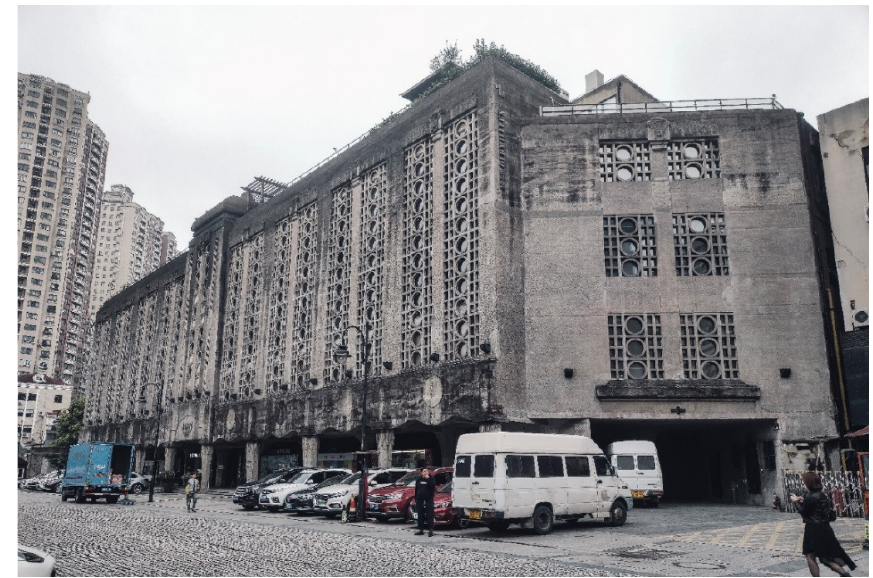
Figure 8. Restored facade of the 1933 Old Millfun (by author 2021).